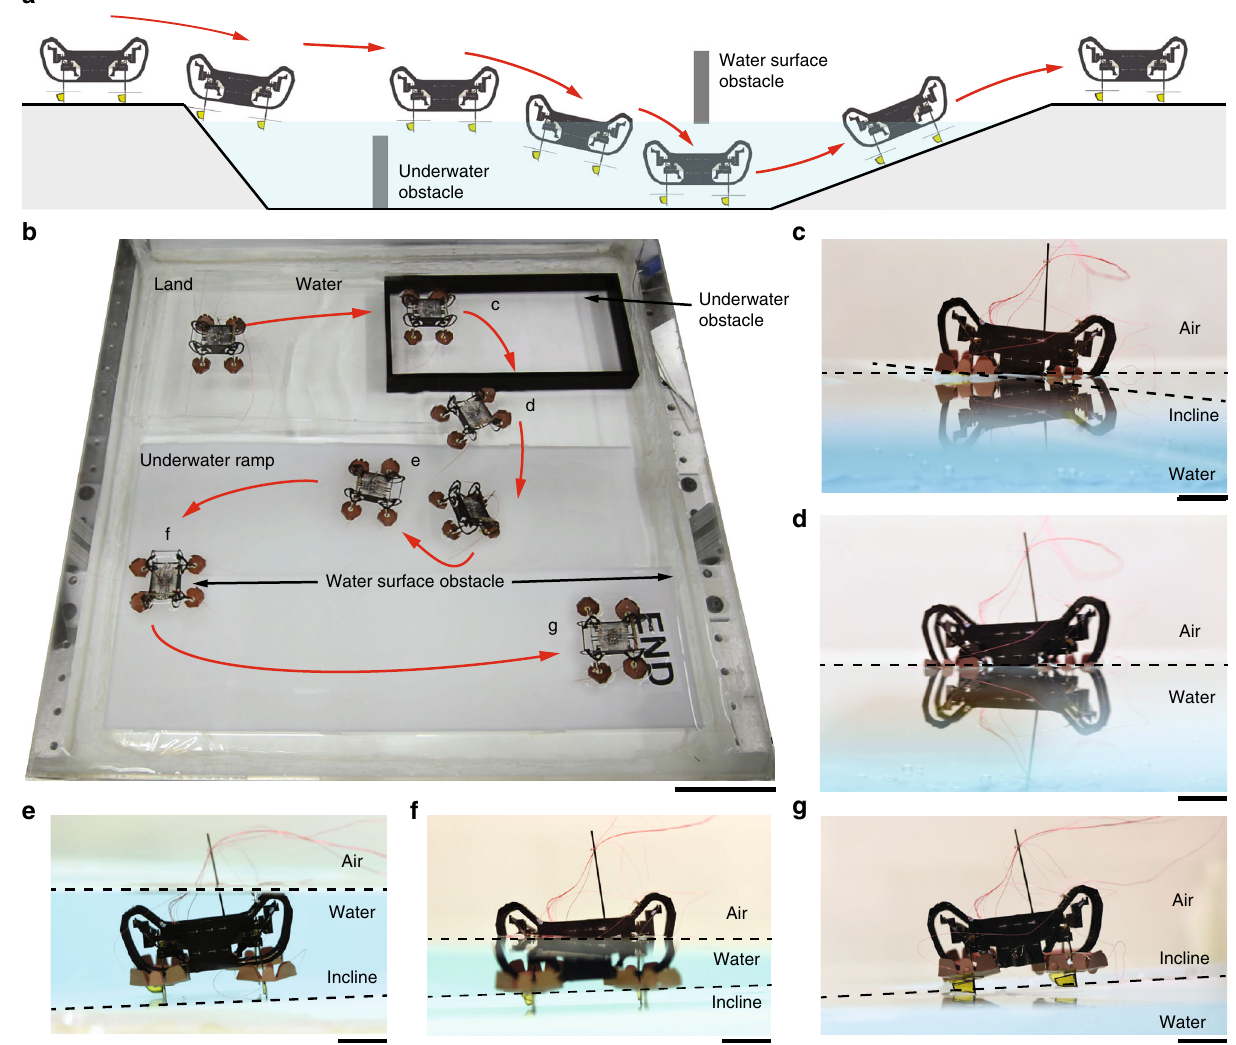
Fig. 2 Robot demonstration. a An illustration of robot locomotion. The robot can walk on level ground, swim on the water surface, dive into water, walk underwater, and make transitions between ground, the water surface, and the underwater environment. b Top view composite image of the robot demonstrating hybrid locomotion described in a . Scale bar, 5 cm. c Side view of the robot walking down an incline and transitioning from land to the water surface. d The robot swims on the water surface. e The robot climbs an incline when it is fully submerged in water. f The robot gradually emerges from the air – water interface. g The robot completely exits water. Scale bars ( c – g ), 1 cm. In c – g , two drops of blue food coloring are added to deionized water